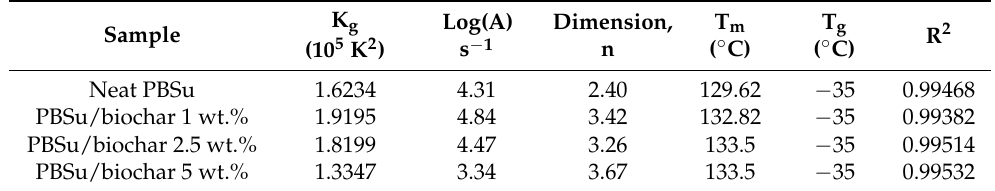
Figure 9. Heat flow curves of ( a ) neat PBSu, ( b ) PBSu/1% biochar, ( c ) PBSu/2.5% biochar, and ( d ) PBSu/5% biochar composites versus temperature and the corresponding fitting of multivariate nonlinear regression of the Nakamura (Nk) model with Hoffman–Lauritzen theory. Table 4. The Nakamura/Hoffman–Lauritzen model parameters of neat PBSu and PBSu/biochar